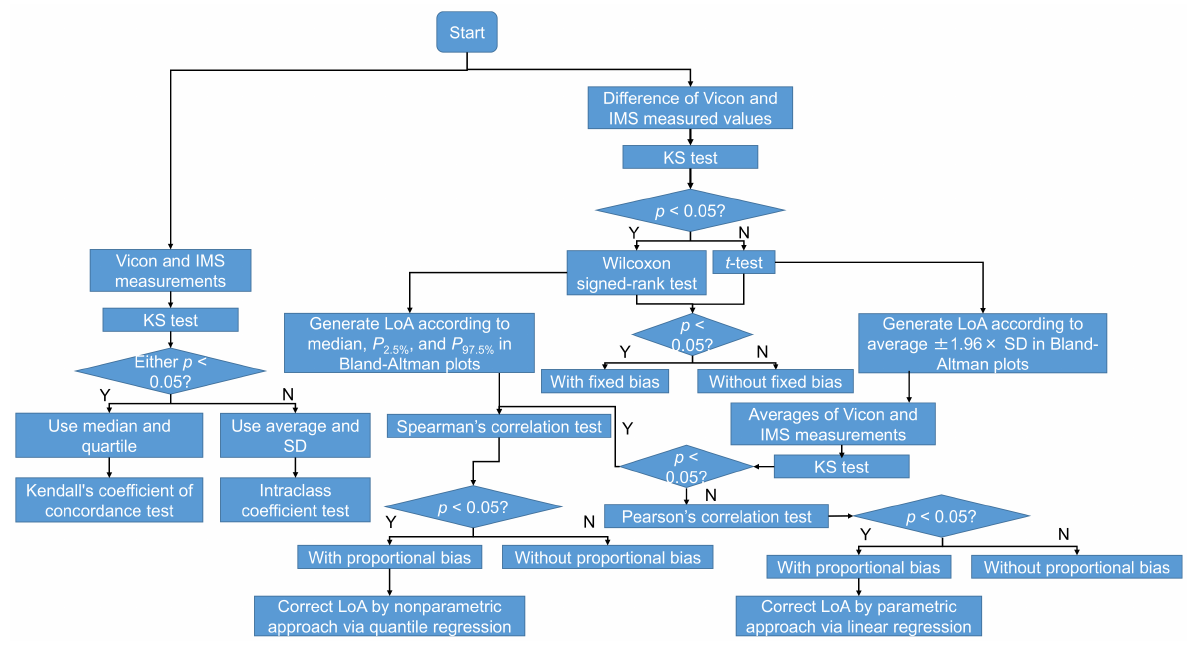
Figure 8. Flowchart of the statistical analysis in this